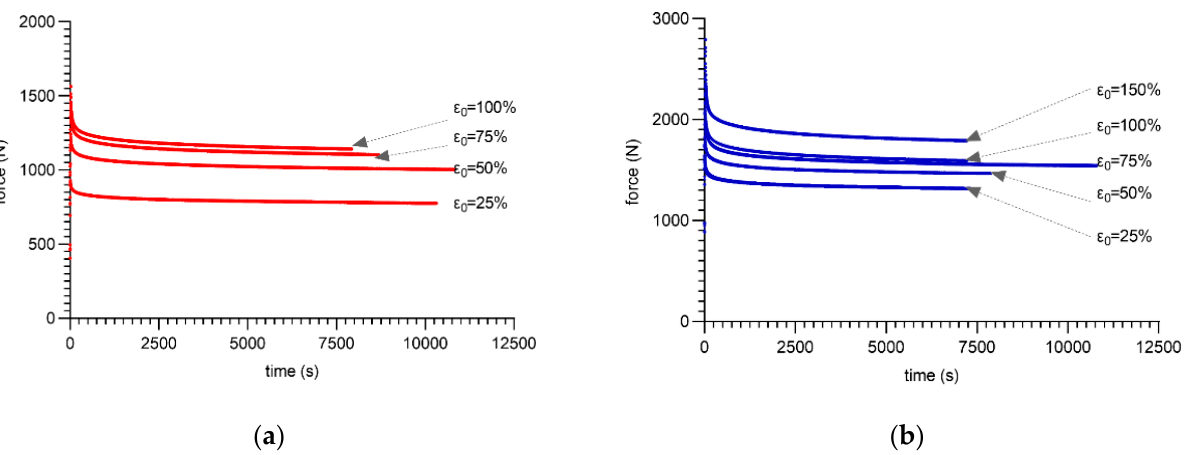
6 of 13 Figure 6. Static load–displacement curves for PS (pure shear) specimens.